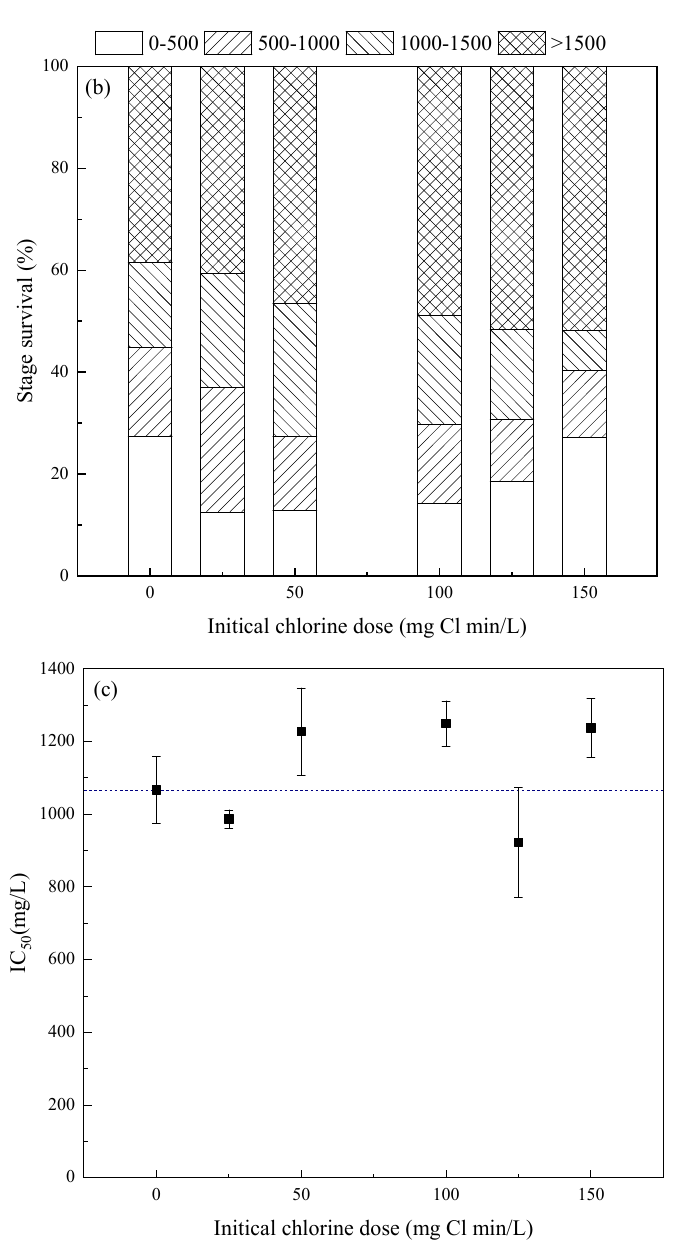
Figure 3. Effects of chlorination on antibiotic resistance characteristics of ARB ( E. coli HB101). ( a ) Dose–response curve of ARB ( E. coli HB101). ( b ) Stage survival of ARB ( E. coli HB101). ( c ) IC 50 of ARB ( E. coli HB101). The error lines represent the standard deviation of 3 replicate experiments.